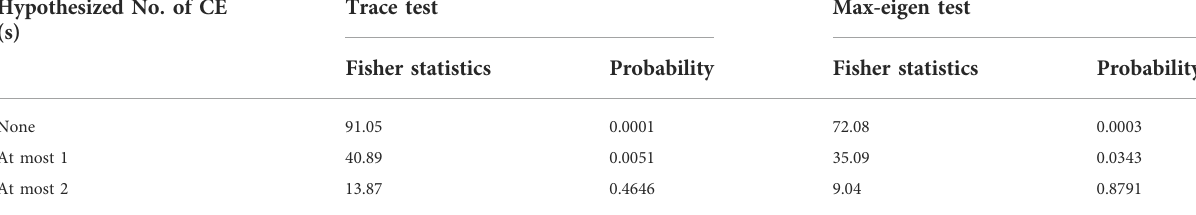
TABLE 7 |Johansen fi sher panel cointegration test results for growth model. Hypothesized No. of CE (s)